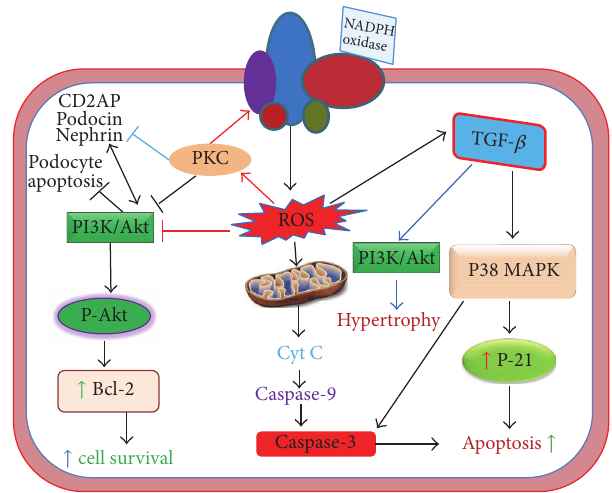
Figure 3: Major signaling pathways for induction of apoptosis and hypertrophy of podocyte and mesangial